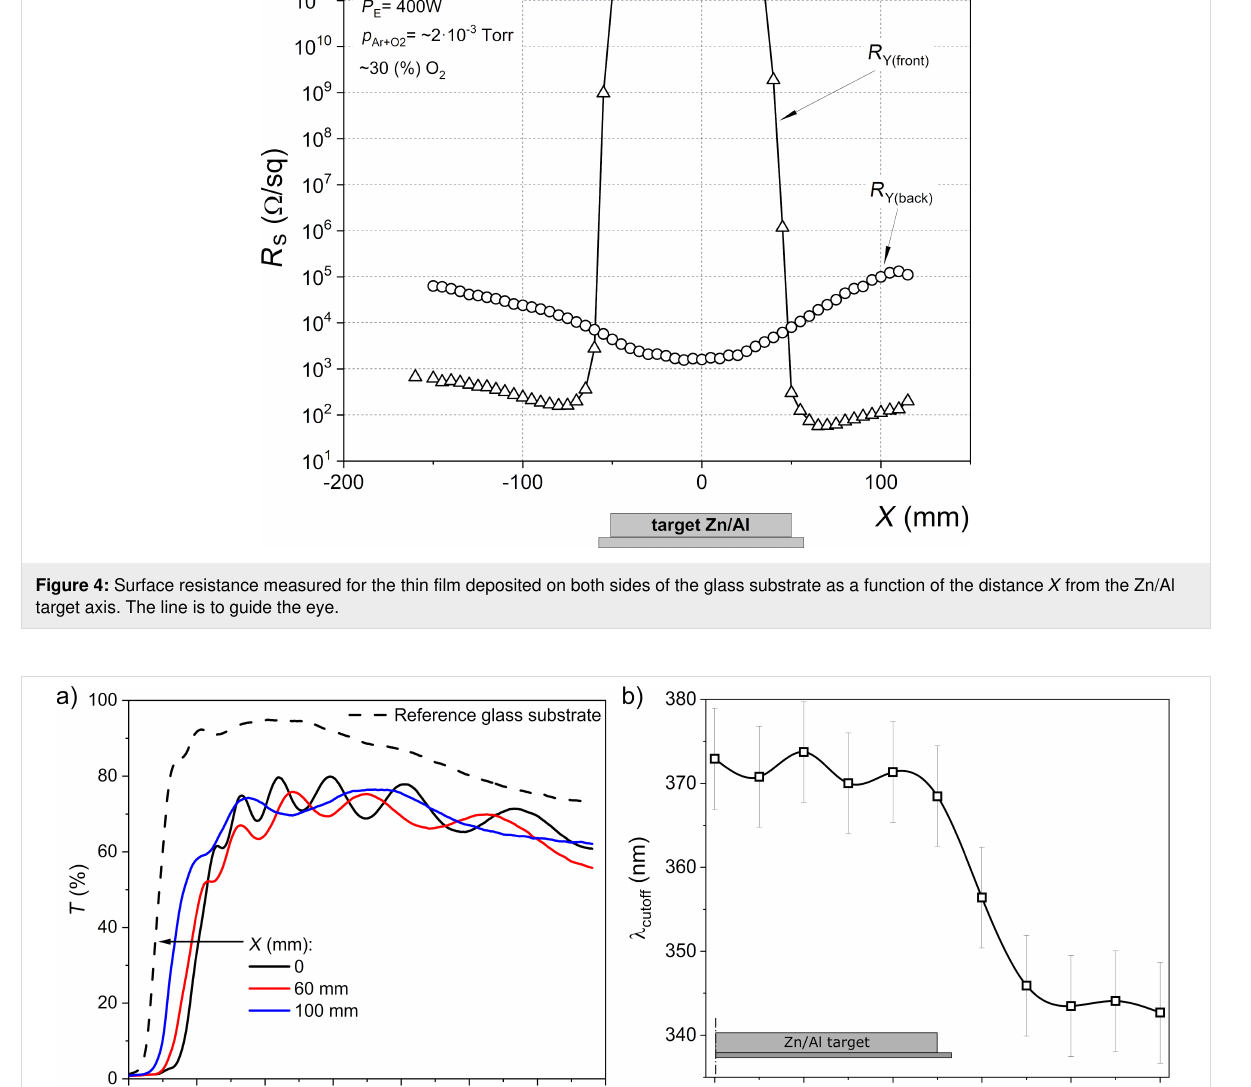
as a function of the distance from the target axis (due to